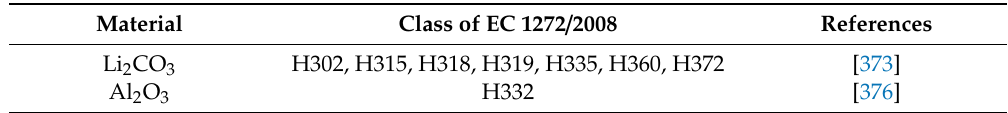
Table 15. Hazard statements of Li 2 CO 3 and Al 2 O 3